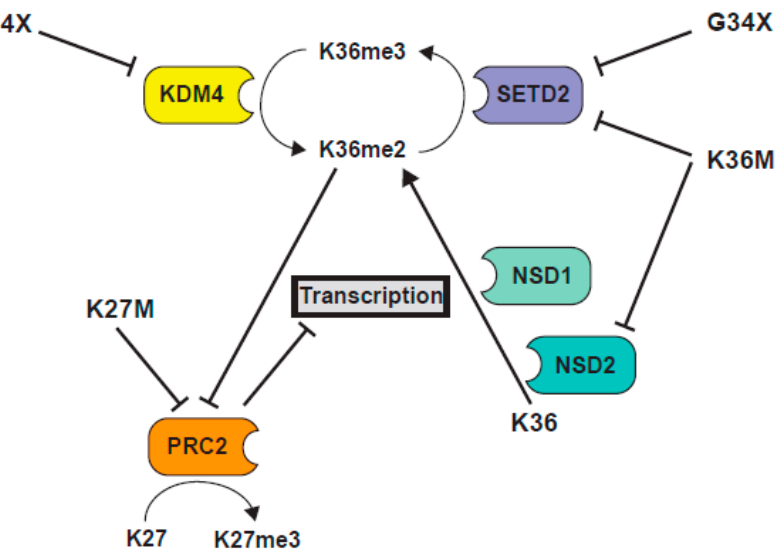
Figure 6. Schematic illustration of the interplay between K36 and K27 methylation pathways in histone mutant cells.